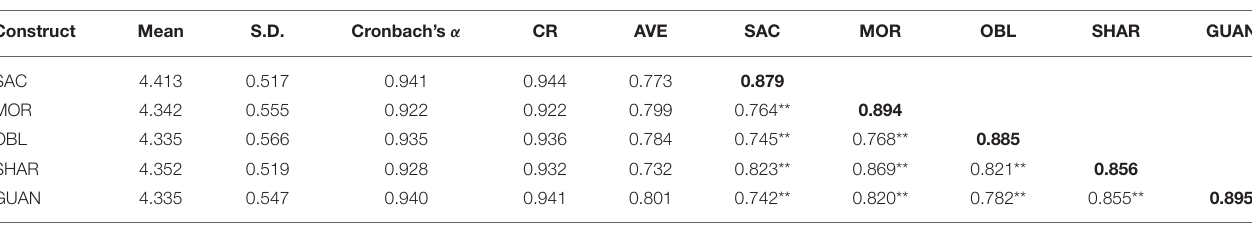
TABLE 2 | Means, standard deviations, AVE and correlations among study variables. Construct